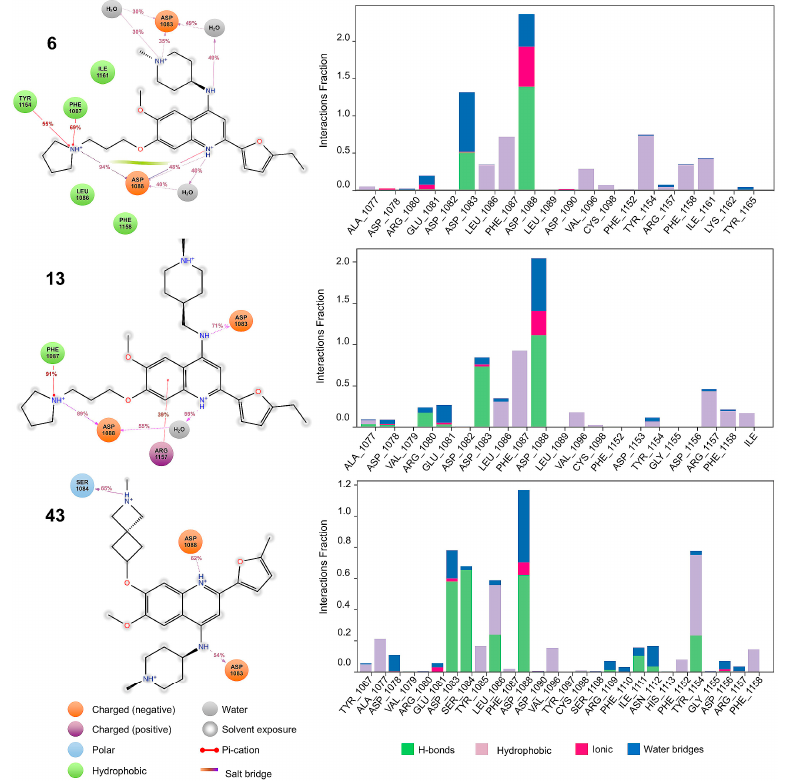
Figure 10. G9a–ligand contact analysis during the 100-ns simulations. The diagrams show the fraction and type of interactions with representative ligands during the simulation. Molecules 2018 , 23 , x FOR PEER REVIEW